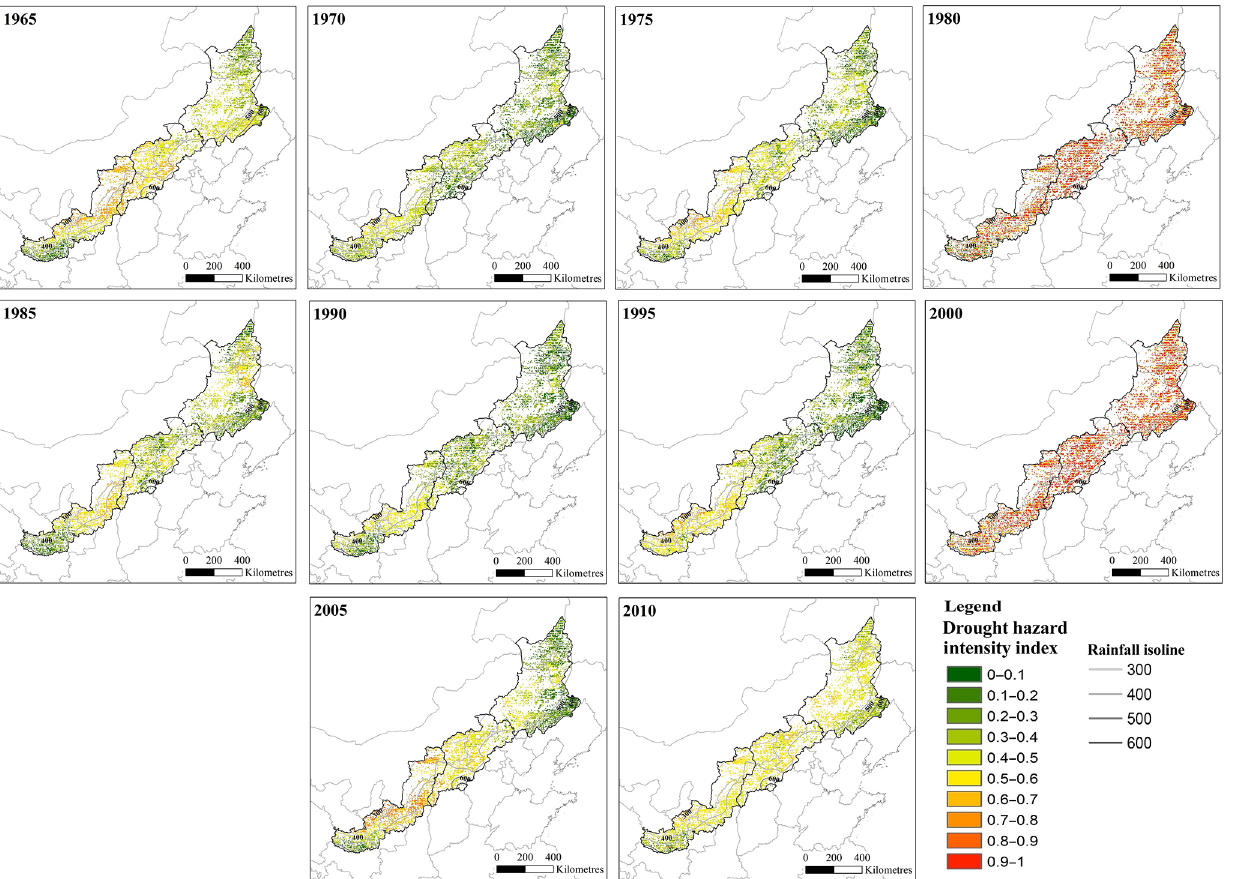
Figure 5. The spatial distribution of spring maize drought hazard intensity index in time